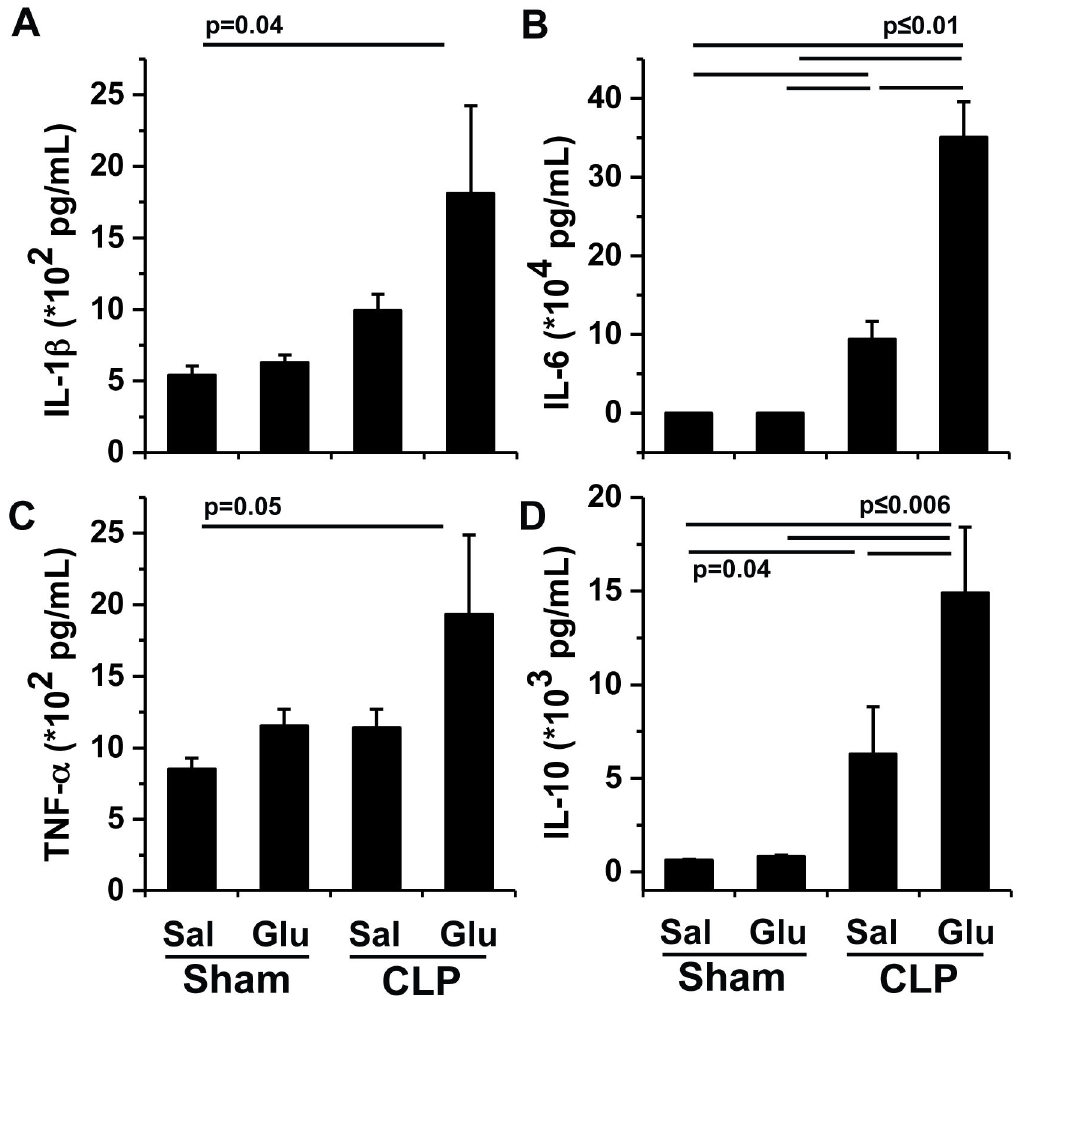
Figure 7. Inflammatory cytokine profiles after cecal ligation and puncture. Mean ± SEM for Interleukin-1β (IL-1β; A), Interleukin-6 (IL-6; B), Tumor necrosis factor-α (TNF-α; C), and Interleukin-10 (IL-10; D) measured in plasma 18 hrs after either CLP or sham surgery and infusion with iv saline (Sal) or glucose (Glu) at 100 µL/hr post-operatively. Statistical differences were determined by two-way ANOVA after log transformation where appropriate with differences between individual means determined by post-hoc Bonferroni